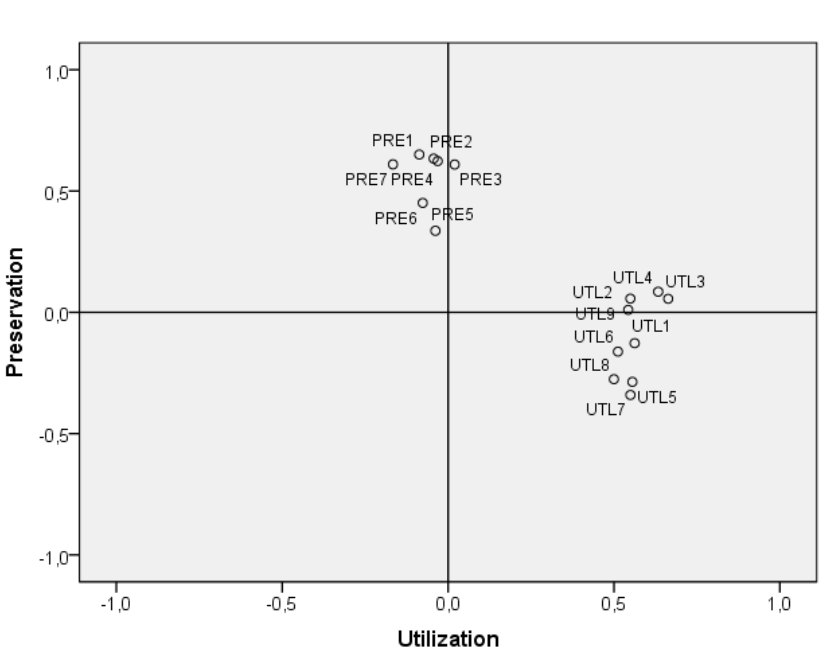
Figure 1. Component plot of the 2-MEV factor solution (see Table 1 for item wording).